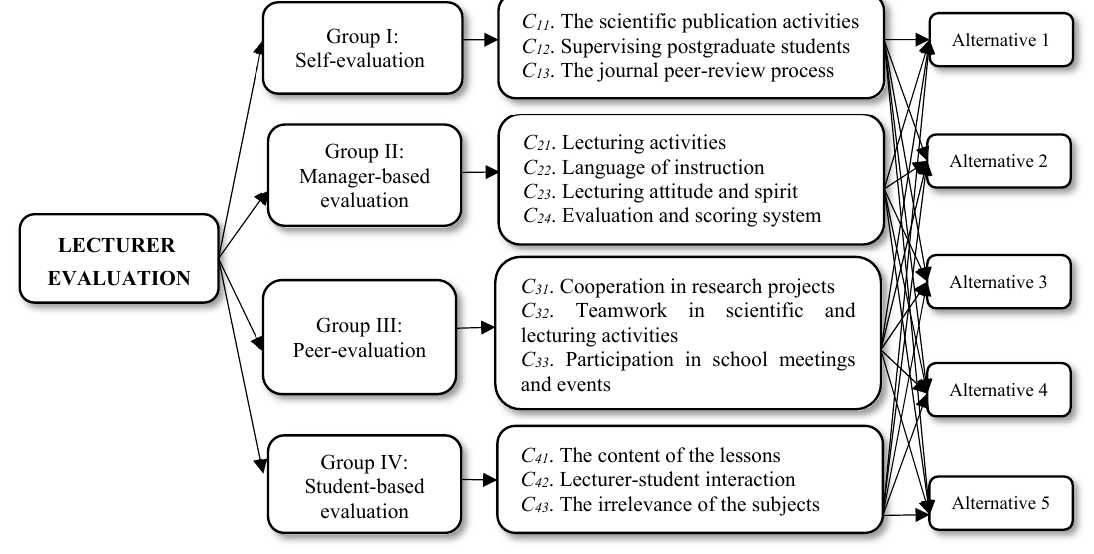
Fig. 1. The criteria used in lecturer